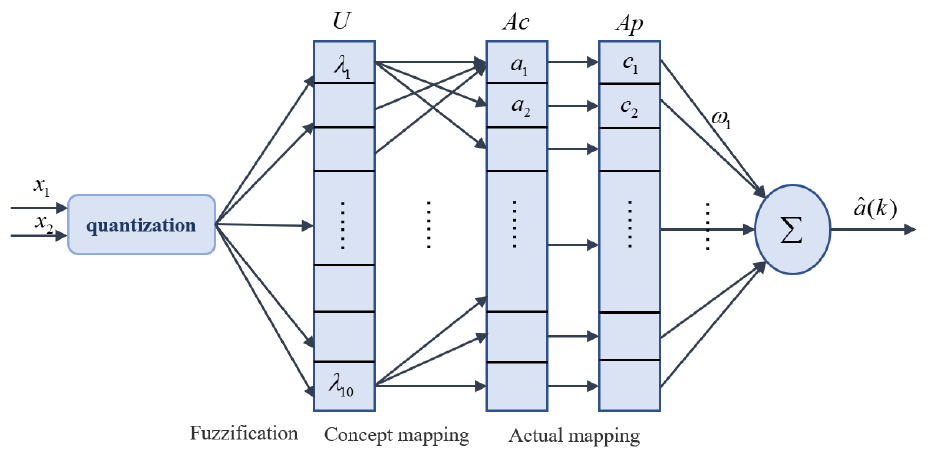
Figure 3. The structure of the